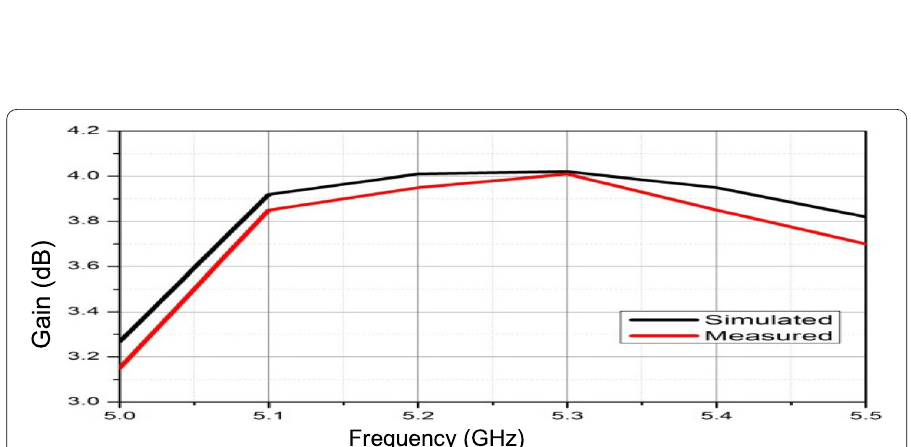
Fig. 4 Measured and simulated gain of reference patch